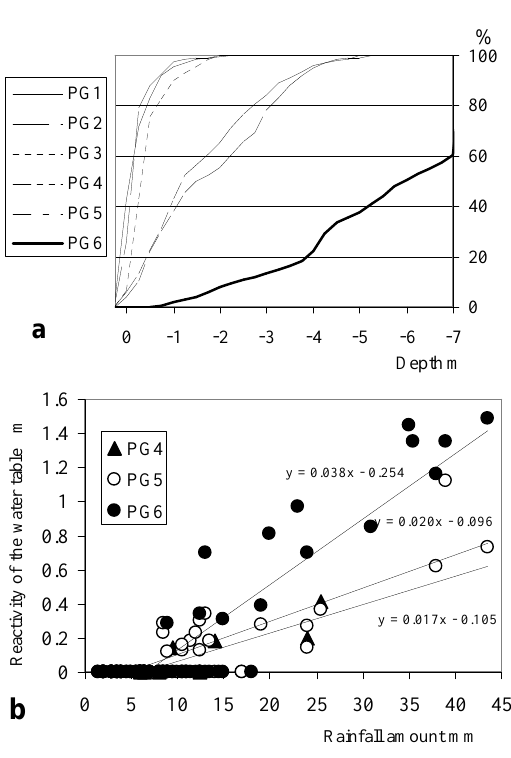
Fig. 3. Variations of the water table depth: (a) Frequency distribution of the water table depth in the six wells, calculated on five water years (1998 to 2002); (b) Reactivity of the water table depth versus rainfall amount, calculated for all the rainfall events of five wet seasons (January to March, from 1998 to 2002 ) (N=88).